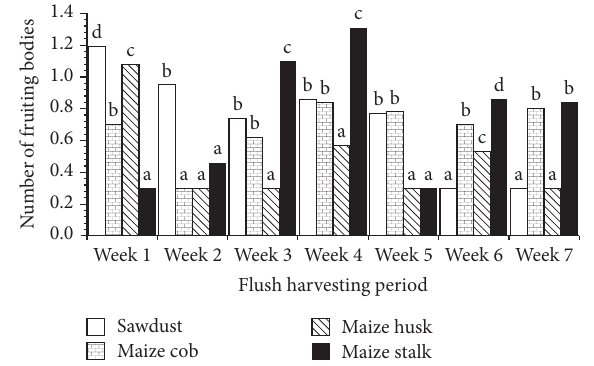
Figure 3: The effect of substrates on the total number of sprouted fruiting bodies in a crop. (1) Bars with the same Arabic letter for substrate material alone or same Greek letter for bran fortified substrates are not significantly different 𝑃 < 0.001 . (2) Substrates with bran contain 8.4% rice bran.